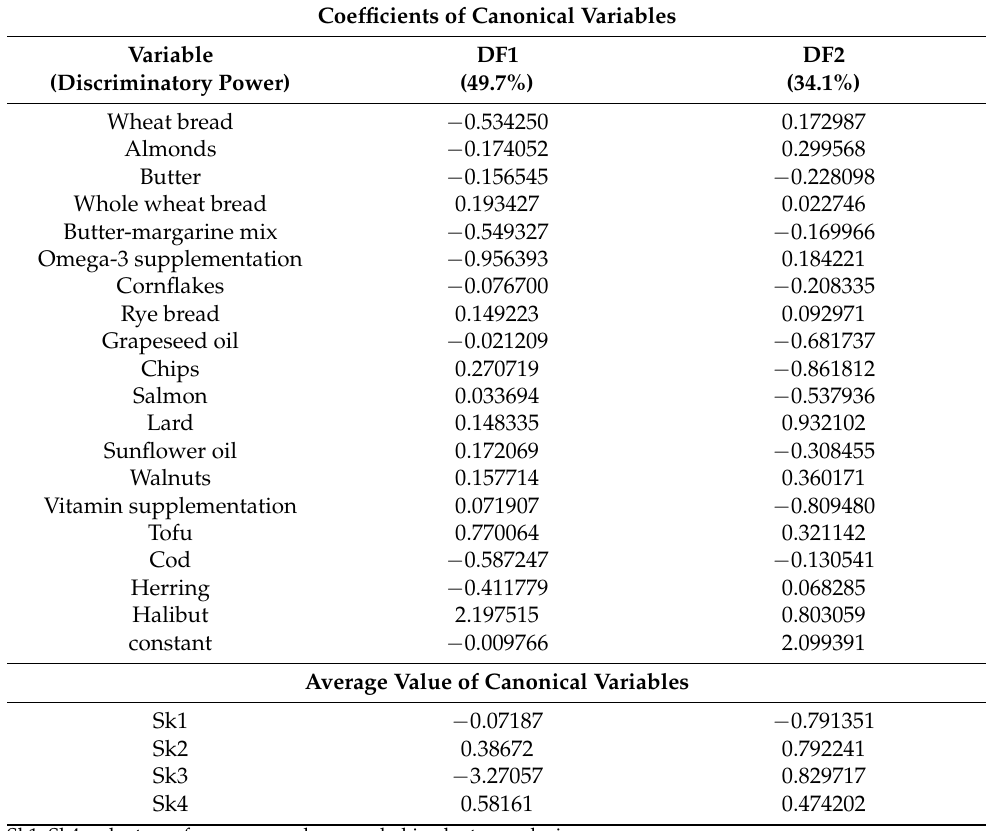
Table A10. Coefficients and average value of canonical variables included in the final model